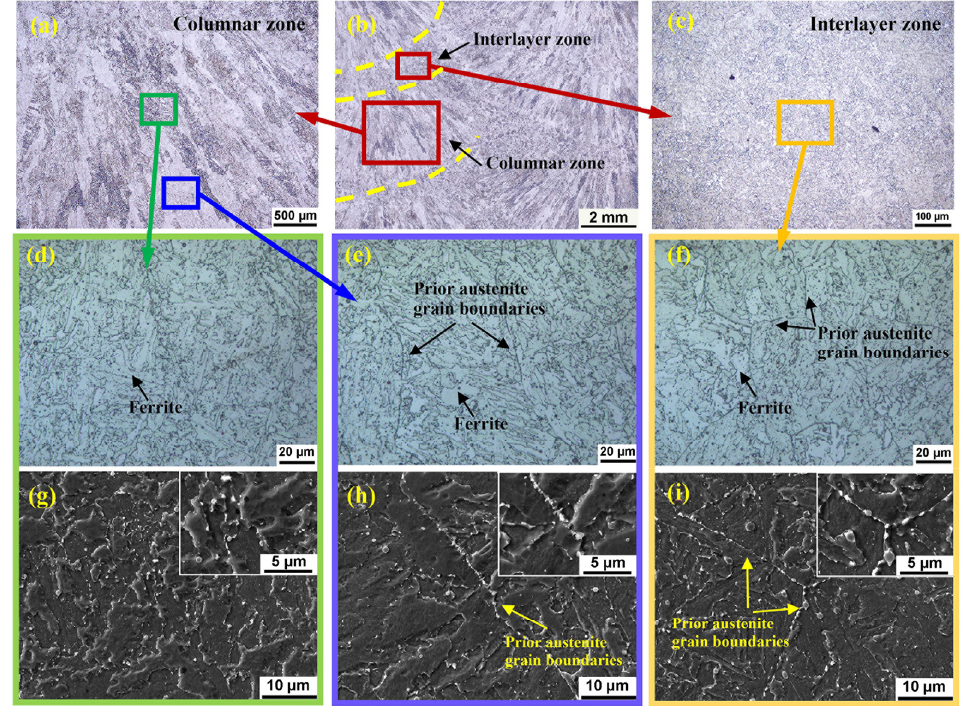
Figure 2. Microstructure of the turbine part WM: ( b ) the entire microstructure of the WM; ( a ) the columnar zone; ( d , g ) the upper part of columnar zone; ( e , h ) the lower part of columnar zone; ( c , f , i ) the interlayer zone.